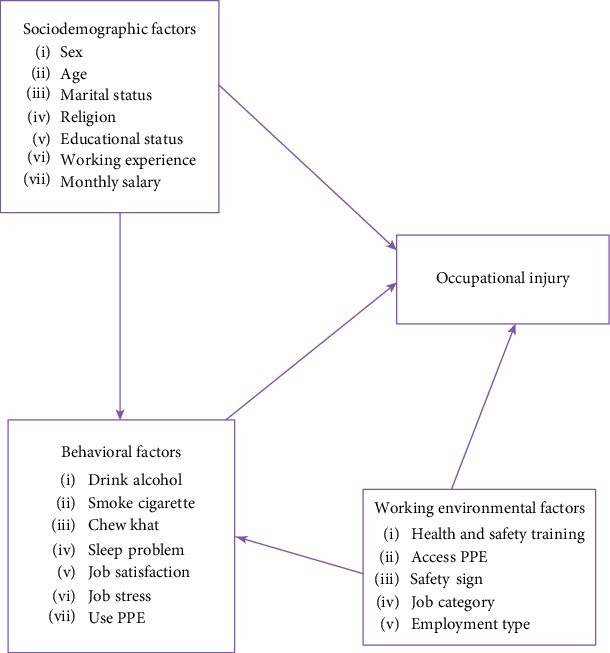
Conceptual framework adapted from the literature review [4, 12, 16].